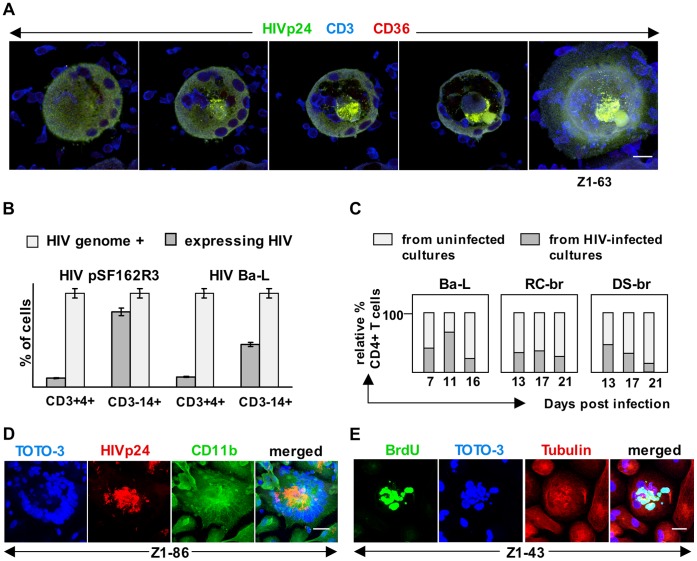
HIV-1 infection dysregulates T-cell development in nurse macrophages.(A) Confocal microscopy images showing an HIV-1-expressing small monocytoid cell (CD36+) budding from the center of a virus-expressing nurse macrophage, as evidenced by colocalization of HIV-1p24 with CD36. Also apparent is that the developing and post-budded CD3+ cells are not expressing HIV-1. This MDM culture was infected with HIV-1 5E14BM, an isolate from bone marrow, and photographed on ∼day 21 post infection. Size bar: 20 µm (B) Latently infected CD4+ T-cells are released from nurse macrophages. Numbers of genome-positive cells were determined by real-time PCR using ACH-2 cells as standards, and then normalized to 100%. Numbers of HIV-1-expressing cells were determined by flow cytometry. The numbers of CD14+ cells harboring HIV genomes also exceeded the numbers expressing HIV-1, but the relative difference was less than that seen for CD4+ T-cells. (C) Fewer CD4+ T-cells are released from nurse macrophages in MDM cultures infected with HIV-1. Nonadherent cells were harvested from infected and uninfected cultures, counted and immunophenotyped using flow cytometry. Cells from 3 or more replicate flasks were pooled. For each harvest, CD4+ T-cell numbers from uninfected flasks were normalized to represent 100%, and the numbers recovered from infected flasks were normalized, proportionately, to represent percent relative to uninfected control. (D) Confocal microscopy illustrating an HIV-1p24-expressing multinucleated giant cell in an MDM culture at D6 following infection with HIV-1 Ba-L. This cell has more than 65 nuclei. The numbers of these cells increased with time. Size bar: 20 µm (E) Abundant BrdU labeling in an HIV-1 Ba-L-infected giant cell. This labeling colocalizes with DNA. Cells were exposed to BrdU for 48 hours, beginning at day 12 post infection. 20 µm. Z numbers indicate the composite Z-stack levels for the images.